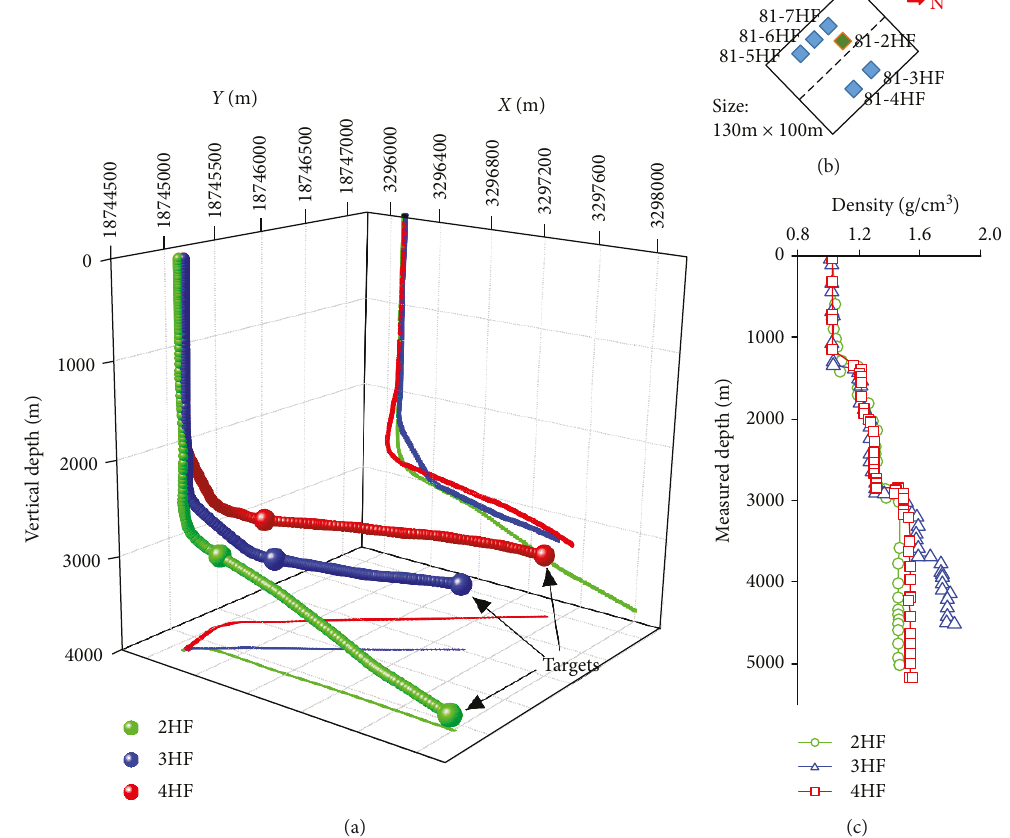
Figure 10: The basic information about the three nearby wells in platform 81: (a) the 3D trajectory and the corresponding horizontal and vertical projections for Well 81-2HF, Well 81-3HF, and Well 81-4HF; (b) the well location layout of platform 81; (c) the drilling fl uid density used in these three